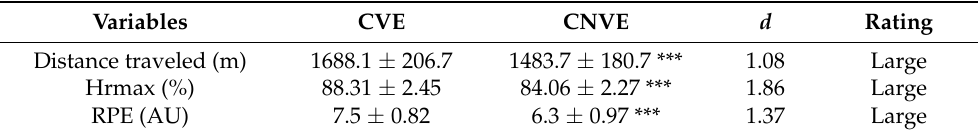
Table 1. Comparison of the distance traveled, Hrmax, and RPE variables between circuit exercise with and without verbal